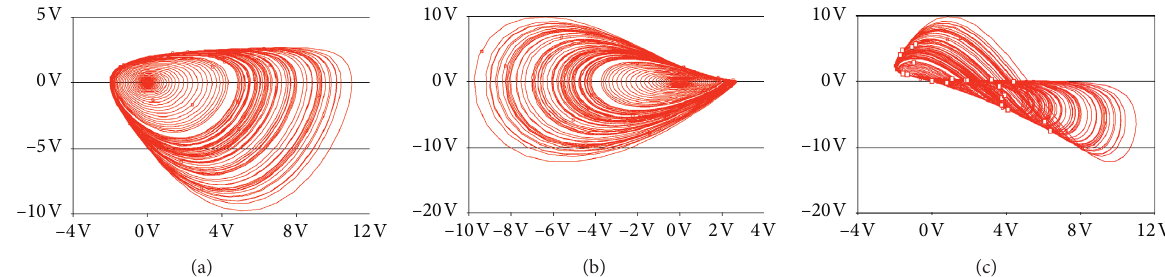
Figure 9: The screenshots of the digital oscilloscope with the 3D jerk system (1) in (a) x